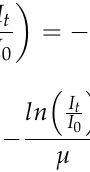
Table 3. Calculated Linear attenuation coefficient of laminated